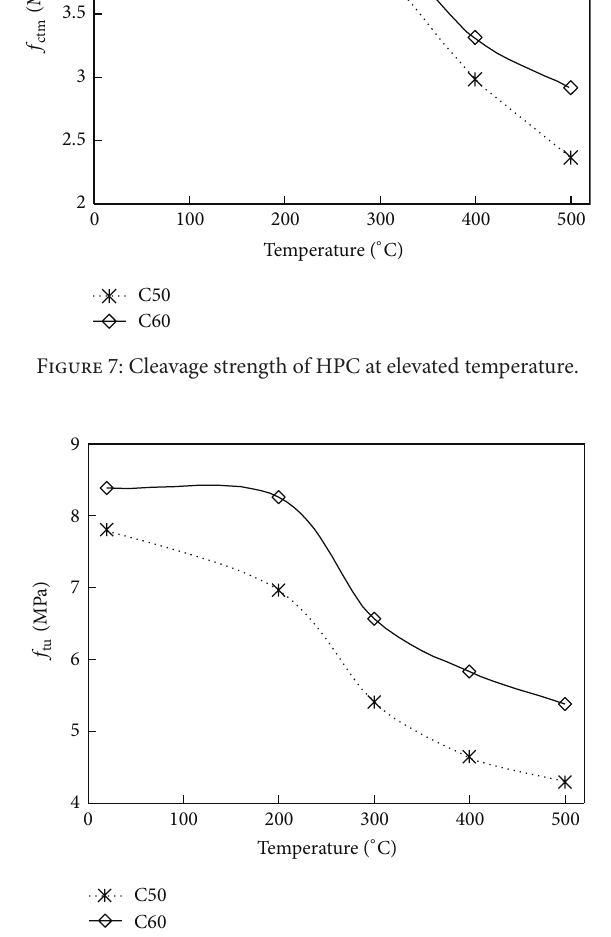
Figure 8: Flexural strength of HPCat elevated